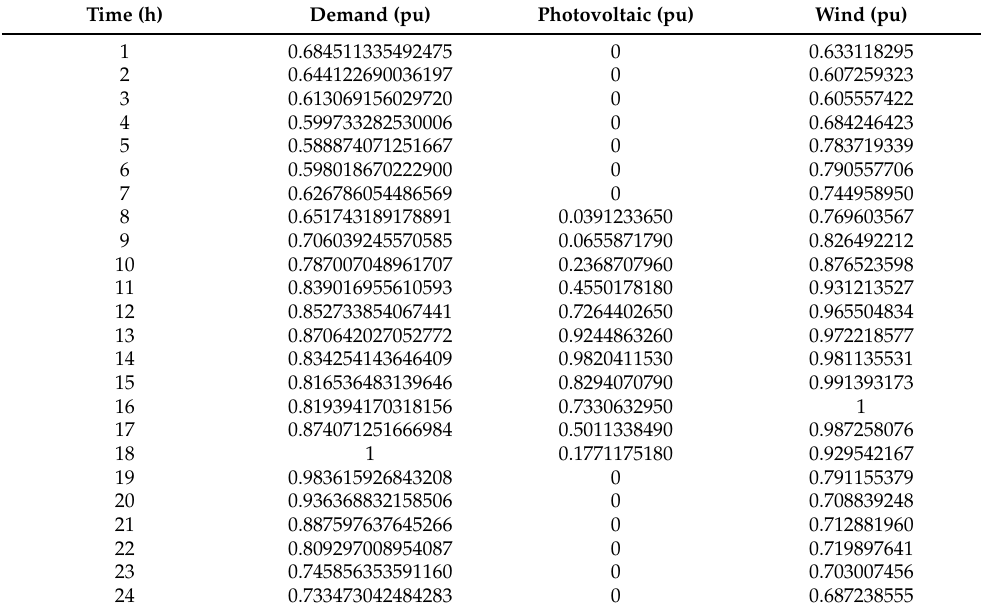
Table 15. Daily demand and generation variation for the 85-bus